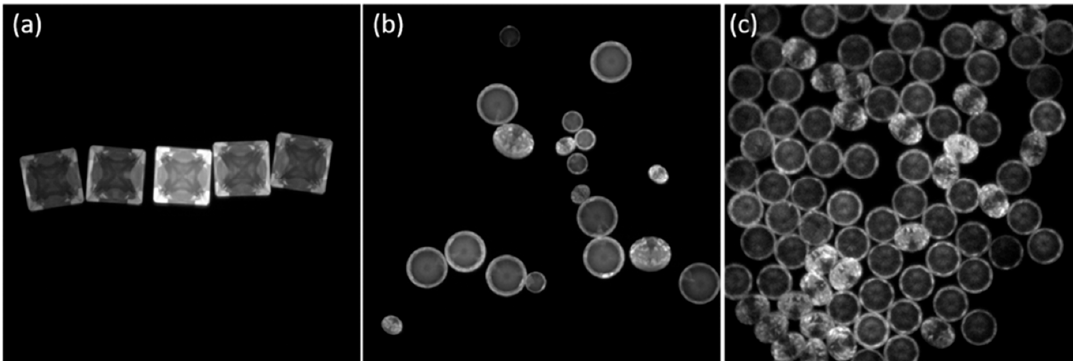
Figure 4. Here; 17 mm × 17 mm field of view, example images of near-infrared emission from CZ from different manufacturers, ( a ) Swarovski 2.75 mm Princess cut, ( b ) Ceres Crystal US: 1 mm and 2 mm Round cut, ( c ) Messi Gems ~1.7 mm Round cut.